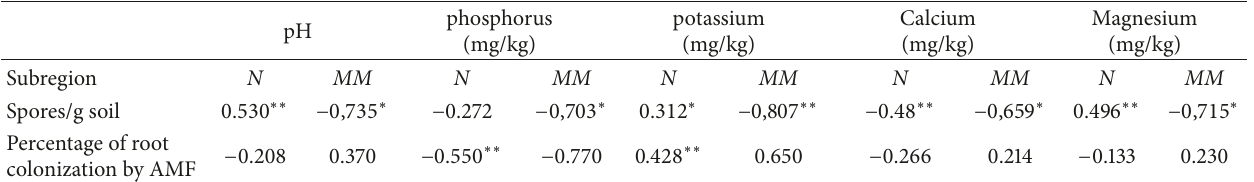
Table 2: Spearman’s correlation (Rho) coefficients between the spore counts, the percentage of colonization, and the physical-chemical properties of the soils studied by